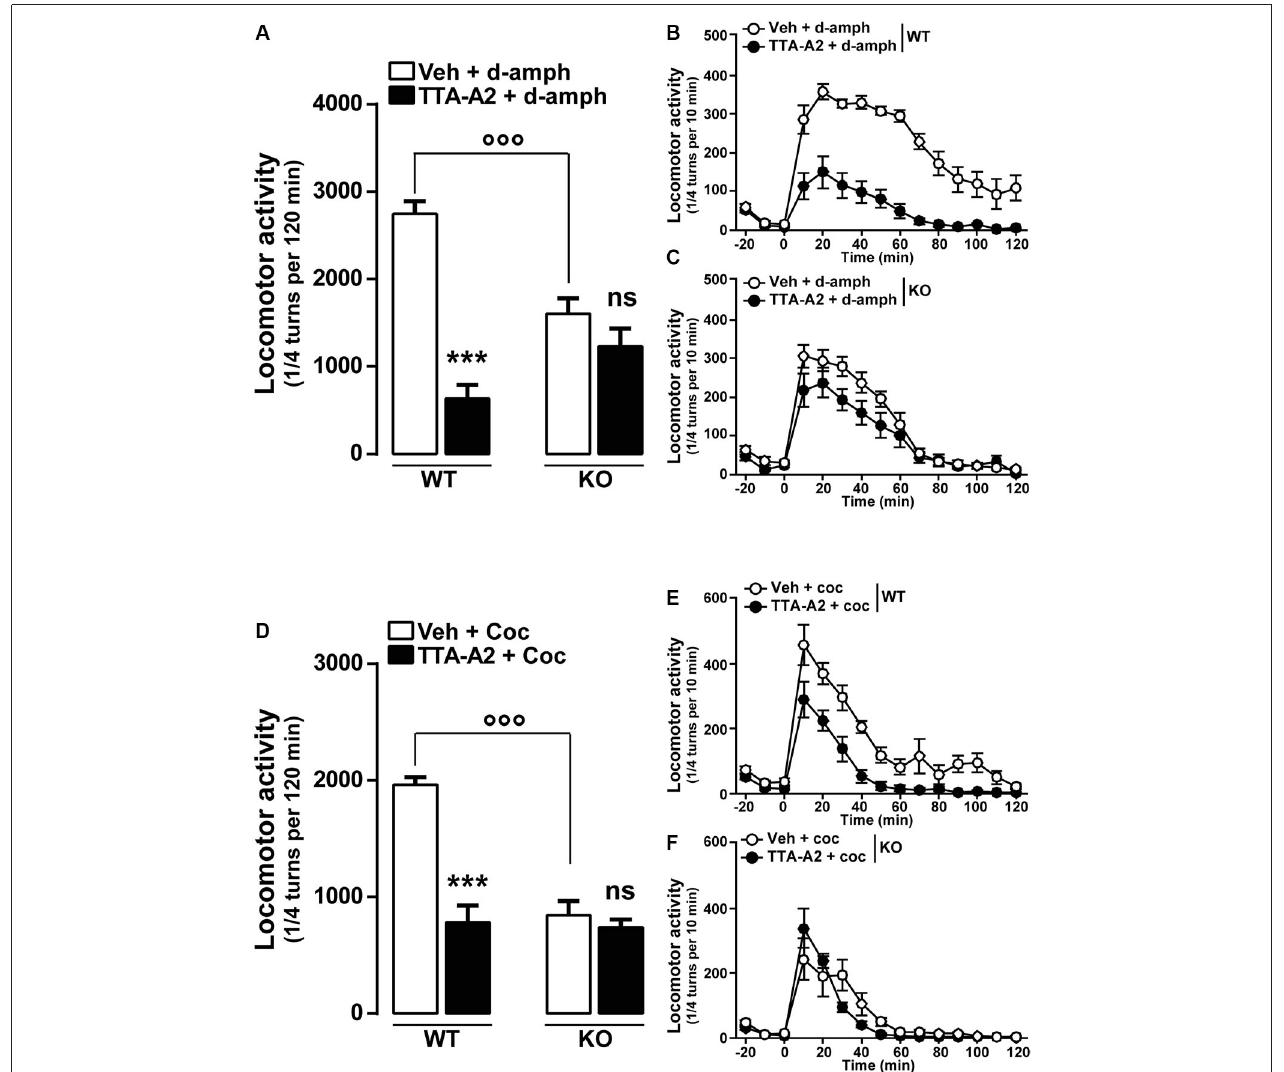
F ( 14,168 ) = 85.72, P < 0.0001; Treatment: F ( 1,12 ) = 2.108, P = 0.1722). (D) Histograms show the effect of TTA-A2 (1 mg/kg, p.o.) on